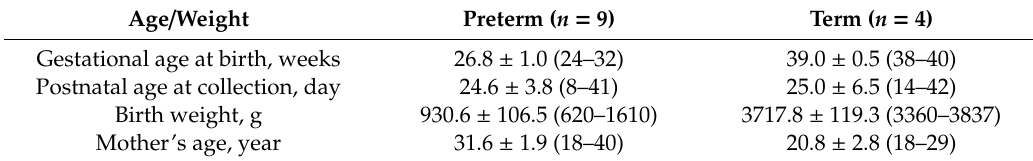
Table 1. Demographic information for the mother–infant pairs sampled for milk and gastric contents. Data are presented as mean ± standard error